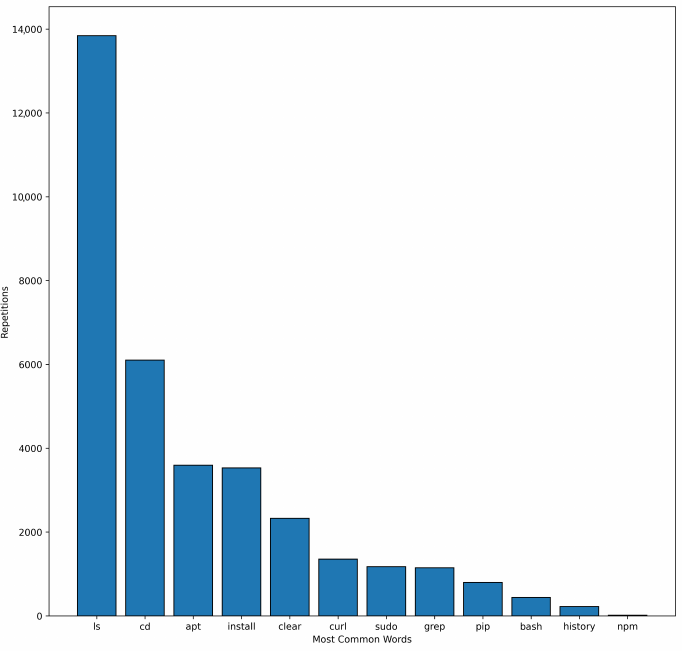
Figure 5. The most frequently met word tokens (bash commands). Table 7. Index representation of words in bash-history.